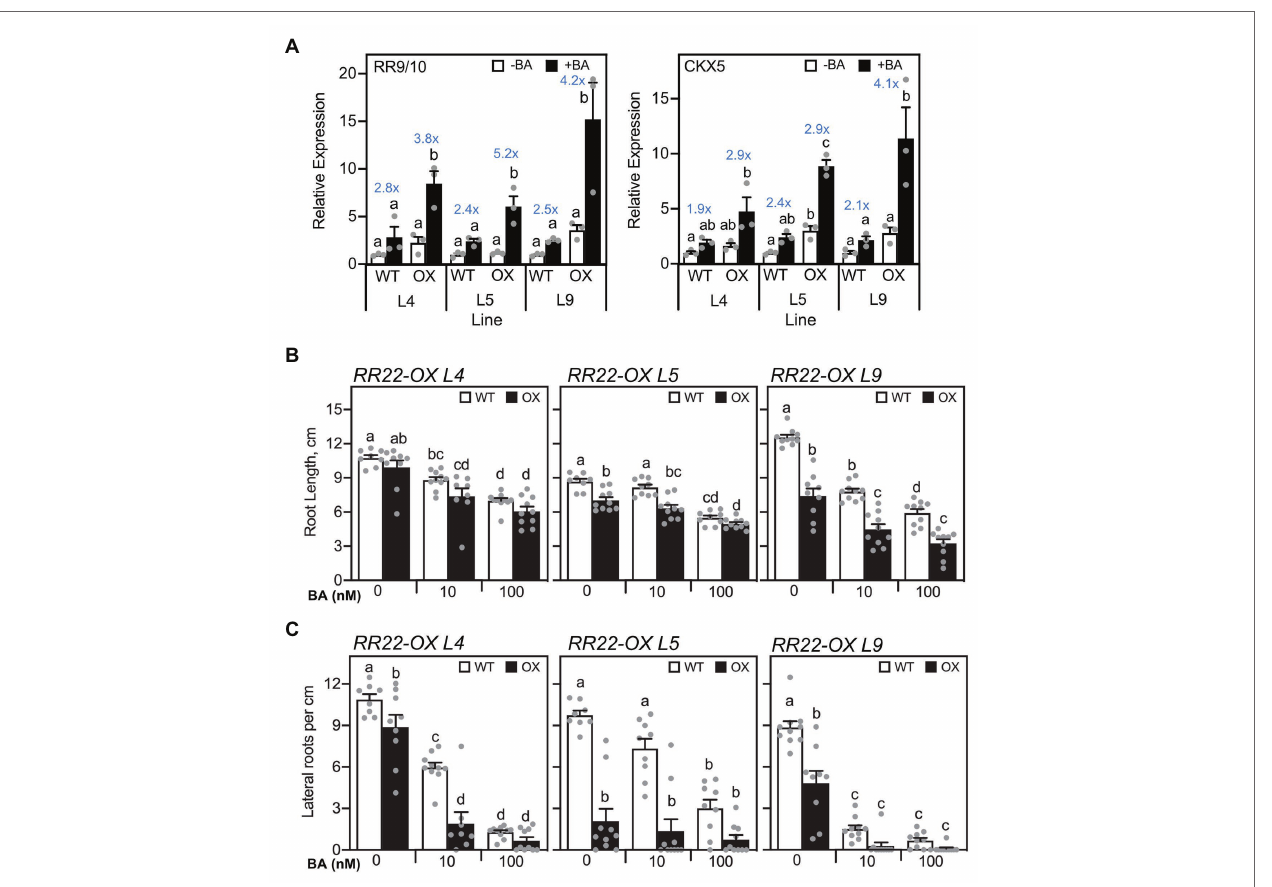
FIGURE 2 | Cytokinin hypersensitive response of RR22-OX lines. (A) Expression of cytokinin-dependent genes based on qRT-PCR. Seven-day-old seedlings were treated with 1 μ M BA or a NaOH vehicle control for 1 h, and gene expression examined in the shoots of the RR22-OX lines and their WT siblings ( n = 3). Expression of the ACT1 gene was used for normalization. The fold change in gene expression is indicated in blue lettering for each BA-treated to untreated sample. (B,C) Root growth response to cytokinin. Seminal root length (B) and lateral root density (C) were determined for 7-day-old seedlings grown on Yoshida hydroponics medium supplemented with a vehicle control, 10, or 100 nM BA ( n ≥ 8). For statistical analyses, ANOVA with a post hoc Holm multiple comparison calculation was performed for each line, involving RR22-OX and the WT sibling of the line. Different letters indicate significant differences at p <